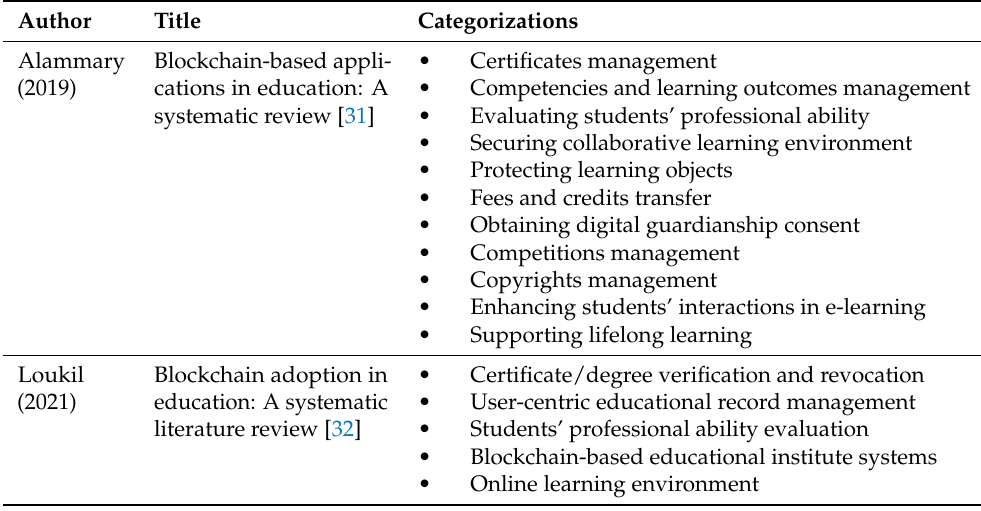
Table 1. The different categorizations from